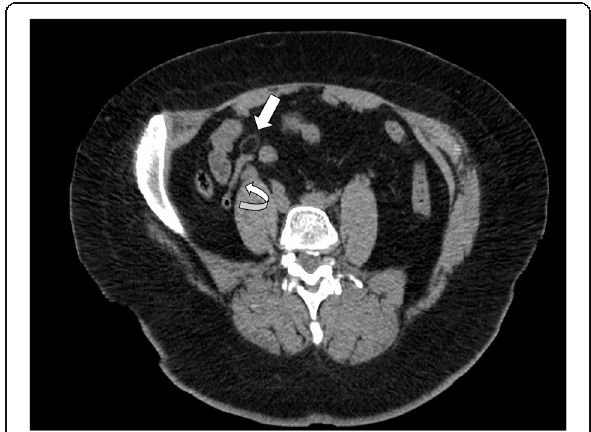
Fig. 9 Acute epiploic appendagitis adjacent to the vermiform appendix in a 39-year-old woman. Curved reformatted non-contrast CT image shows an oval lesion with fat attenuation and peripheral hyperdense rim (arrow), that is depending directly from